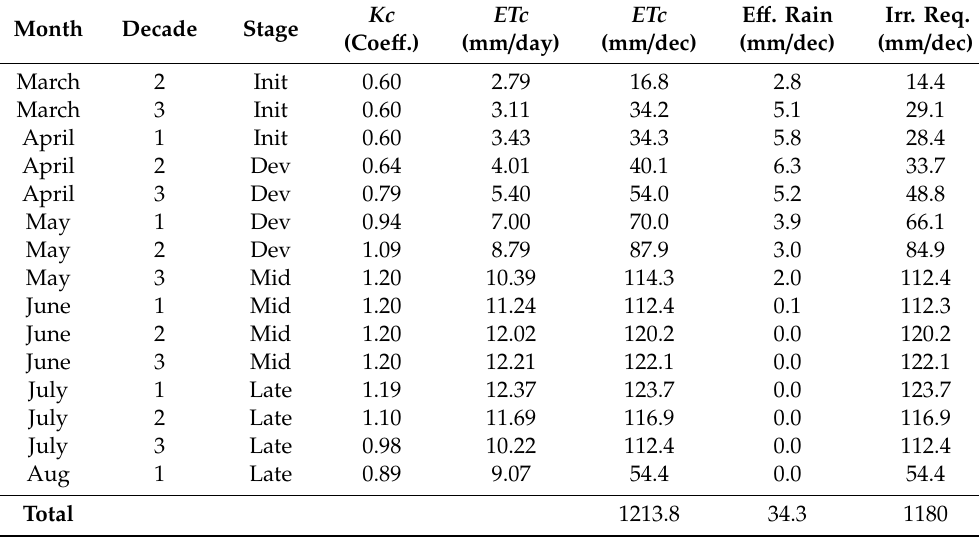
Table 6. Crop water requirement for